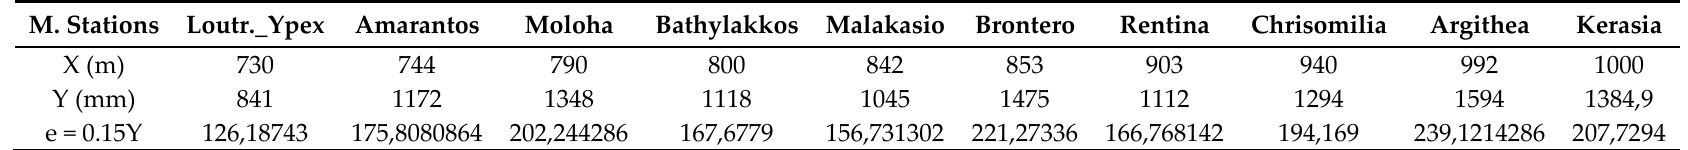
Table 2. Elevation and Rainfall data from meteorological stations of Central